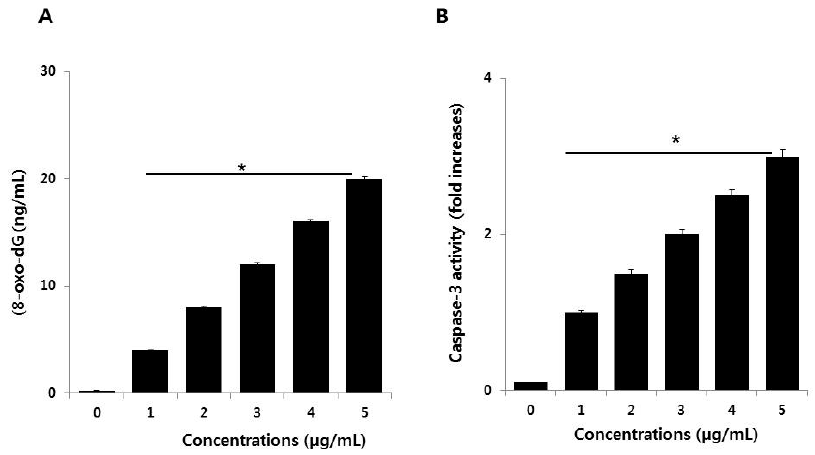
Figure 7. ( A ) Palladium nanoparticles (PdNPs) induce DNA damage and ( B ) activate caspase 3 in SKOV3 cells. The treated groups showed statistically significant differences compared to the control group, as determined by the Student’s t -test. (* p < 0.05).